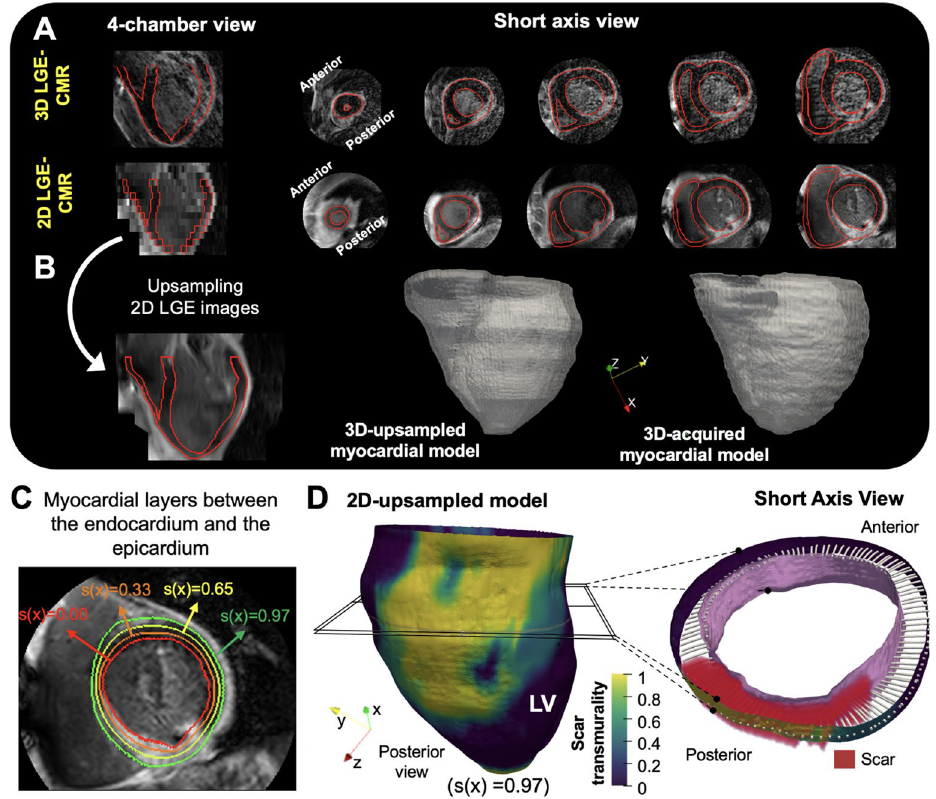
Figure 3. Three-dimensional transmural-based scar assessment. ( A ) Long-axis and short-axis views of 2D and 3D LGE-CMR images from the same patient. ( B ) Resolution upsampling from 2D images and representative 3D-upsampled and 3D-acquired myocardial models. ( C ) Wall segmentation for scar transmurality analysis at different layers. ( D ) Representative transmurality map from a 3D-upsampled model with a short axis view at high-magnification to illustrate the 3D methodology for transmural-based scar assessment. LV: left